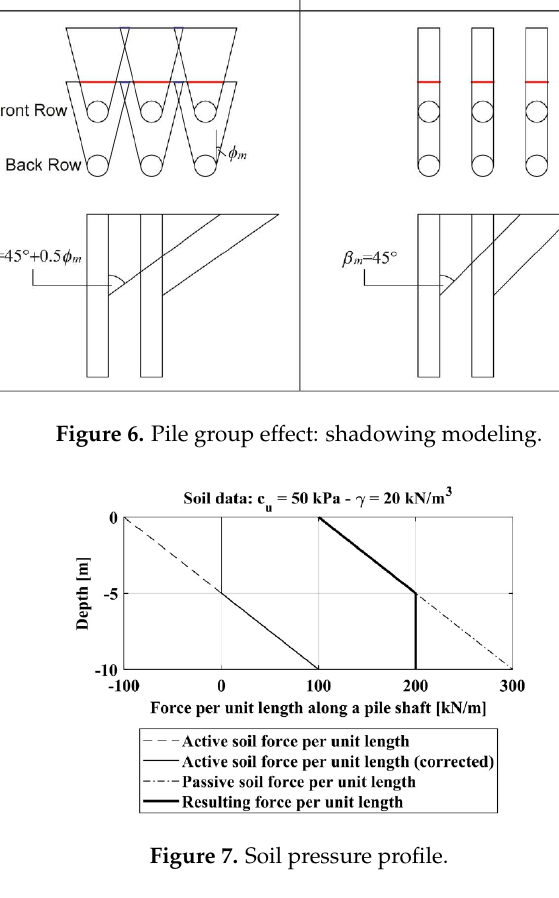
Figure 6. Pile group effect: shadowing modeling.